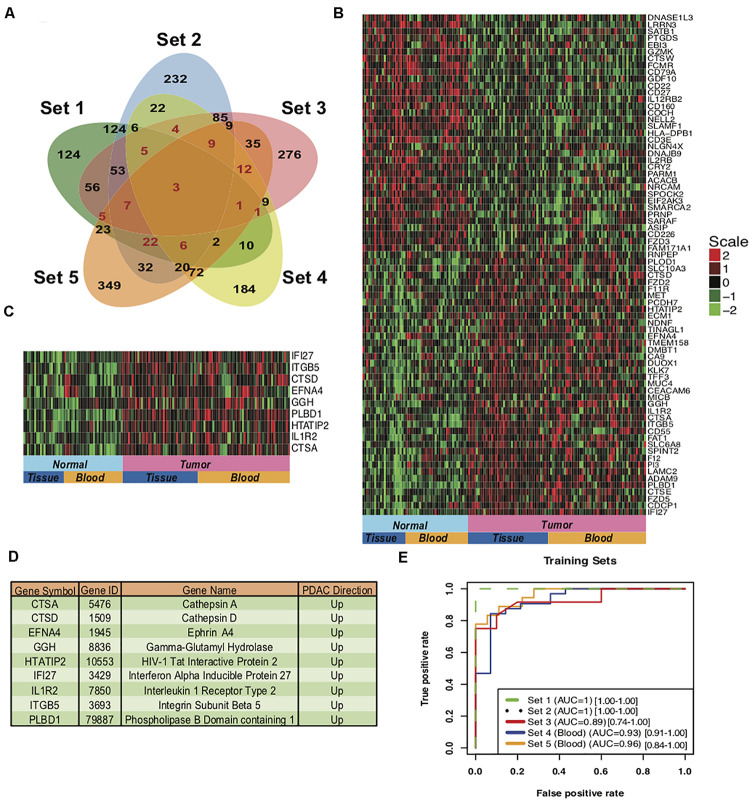
Meta-signature of genes that are consistently DE in multiple datasets and candidate PDAC diagnostic biomarker panel. (A) Venn diagram of the five training datasets for the DE genes. 74 genes (marked in red) with concordant directionality are common to at least 2 of the 3 tissue datasets (Set 1 to Set 3) and one of the 2 blood datasets (Set 4 and Set 5). (B) Heatmap of the 74 meta-signature genes DE in PDAC from five training datasets. Red = upregulated, Green = downregulated. (C) Heatmap of the 9-upregulated marker genes in training sets for PDAC biomarker panel. (D) Description of the genes from the 9-gene based PDAC biomarker panels. (E) AUC plot [CI: 95%] for 9-gene PDAC classifier across the five training sets using leave one out cross-validation (LOOCV). Set1 and Set 2 are matched normal samples i.e., obtained from same individual. Set 3 normal samples are not matched, Normal samples are obtained from the patients undergoing surgery with other pancreatic diseases. Set 4 and Set 5 are blood sourced studies therefore the normal subjects were matched for gender, age and habits.